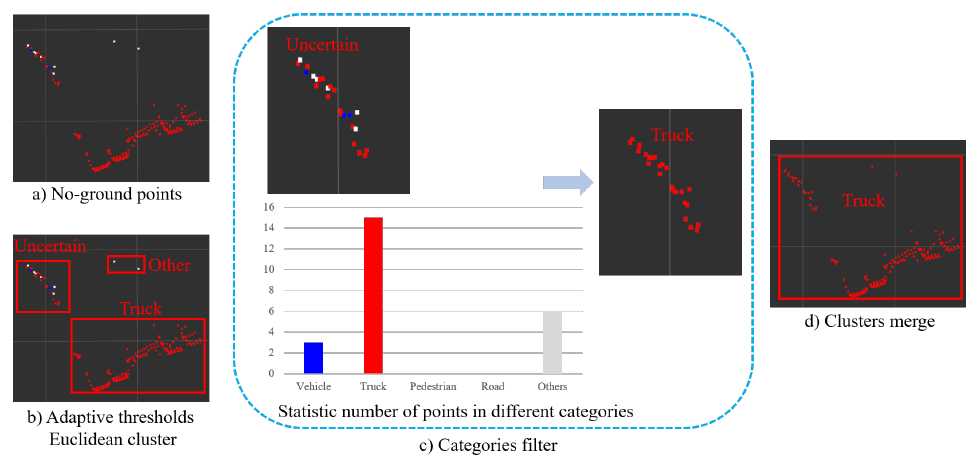
Figure 7. Pipeline of the clustering method combining adaptive distance threshold Euclidean cluster- ing with semantic segmentation category